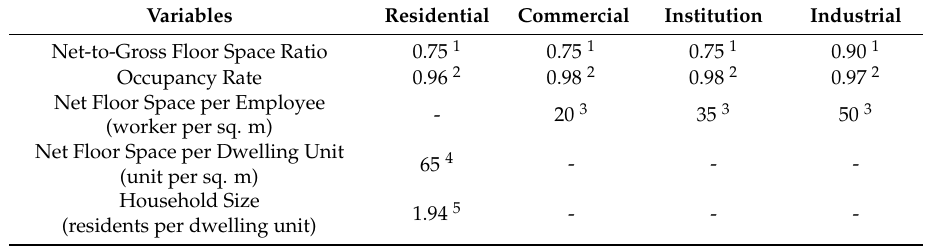
Table 5. Data input for the population and employment estimation of five station areas in Tokyo in 2015.